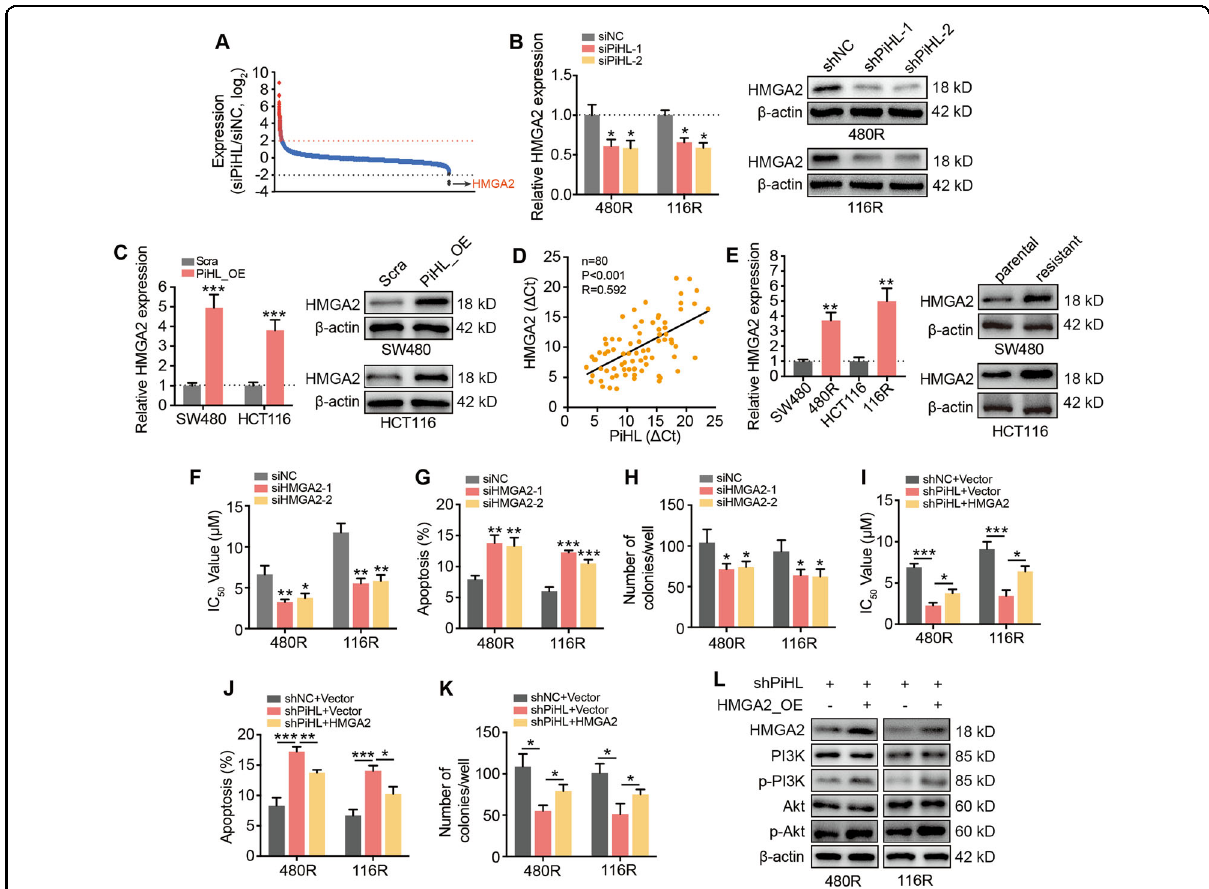
Fig. 4 PiHL targeting HMGA2 is required for PiHL-mediated CRC drug resistance. A Changes in the expression of cancer-related genes in response to siPiHL treatment compared to siControl are shown. The colored circles indicate genes that are up-regulated (red) or down-regulated (gray) under PiHL-depleted conditions. Changes in the expression of the highlighted genes were experimentally con fi rmed by qRT-PCR. B HMGA2 levels regulated by PiHL in Oxa-resistant CRC cells were con fi rmed by qRT-PCR (left) and western blotting (right). C HMGA2 levels regulated by PiHL in parental CRC cells were con fi rmed by qRT-PCR (left) and western blotting (right). D Correlation between HMGA2 and PiHL from our CRC cohort. n = 80, Pearson correlation. E HMGA2 expression in Oxa-resistant and parental CRC cells was analyzed by qRT-PCR (left) and western blotting (right). F – H CCK-8 ( F ), fl ow cytometry ( G ), and colony formation assay ( H ) were used to determine cell survival, apoptosis, and growth of Oxa-resistant CRC cells with HMGA2 knockdown treated with 5 μ M oxaliplatin for 72 h. I – K CCK-8 ( I ), fl ow cytometry ( J ), and colony formation assay ( K ) were used to determine cell survival, apoptosis, and growth of Oxa-resistant CRC cells under shNC + Vector, shPiHL + Vector, or shPiHL + HMGA2 conditions treated with 5 μ M oxaliplatin for 72 h. L Levels of HMGA2 and PI3K/Akt signaling were tested by western blotting in Oxa-resistant cells with indicated treatment. Data are presented as the mean ± SD. * P < 0.05, ** P < 0.01, *** P <